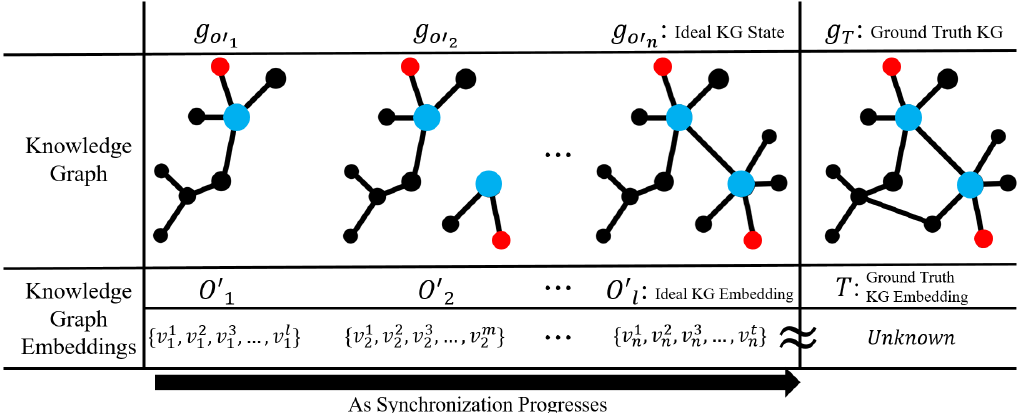
Figure 4. Progression of knowledge graph output as the synchronization process takes place. As the synchronization process progresses, one can see the KGs slowly start to resemble the Ground Truth KG. As it is impossible to know what the ground truth KGs true embedding is, we hypothesize that the ideal constructed KG will have similar embeddings to that of the ground truth